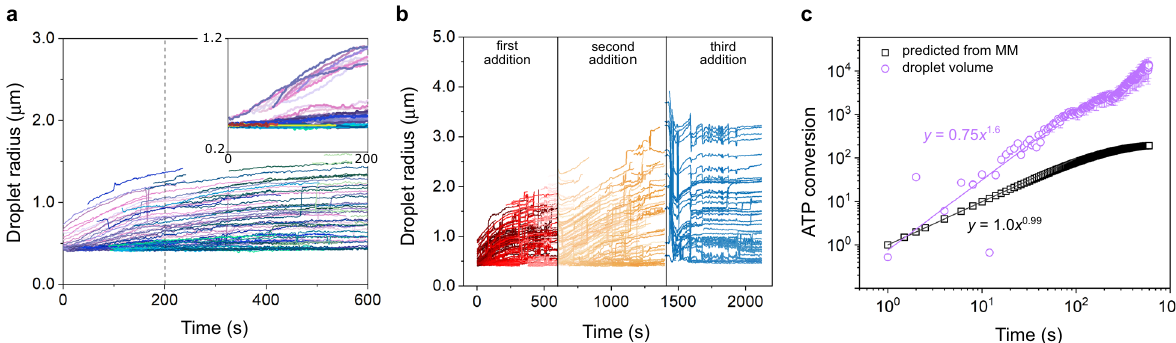
Fig. 5 Growth of active droplets. a Radius traces of all droplets in a selected active droplet experiment (original: video 6). In the inset, the curves were shifted horizontally for better visualization of common behaviour. b Stepwise addition of fuel (PEP) to active droplets. In each step, 1 mM of PEP was added, after the growth curve plateau was reached. Original videos: 9, 10, and 11, respectively. Source videos are provided in Supplementary Data 1. A complete overview of experimental conditions and sample size can be found in Supplementary Table 1. c Pro fi le of the ATP conversion based on average droplet volume evolution (calculated from the dataset in ( a )), compared to the pro fi le estimated based on Michaelis – Menten kinetics in solution, using k 2 of 0.3 min − 1 and ADP starting concentration of 3 mM. The solid lines are power-law fi ts to the initial 60 seconds of growth ( R 2 > 0.9, outliers not included). The calculated conversions have been normalized such that the initial slopes cross at (1,1). Note that the ATP conversion in growing droplets and solution cannot be compared directly, since the exact droplet volume fraction is